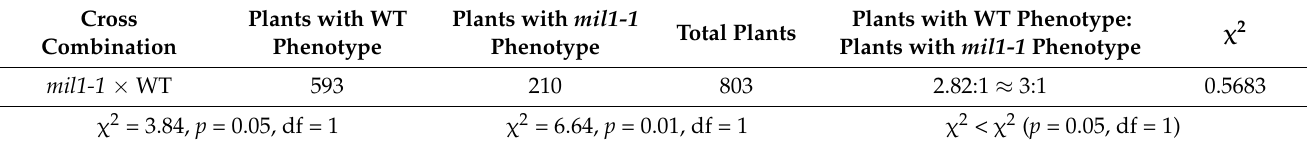
Table 1. Genetic analysis of mil1-1